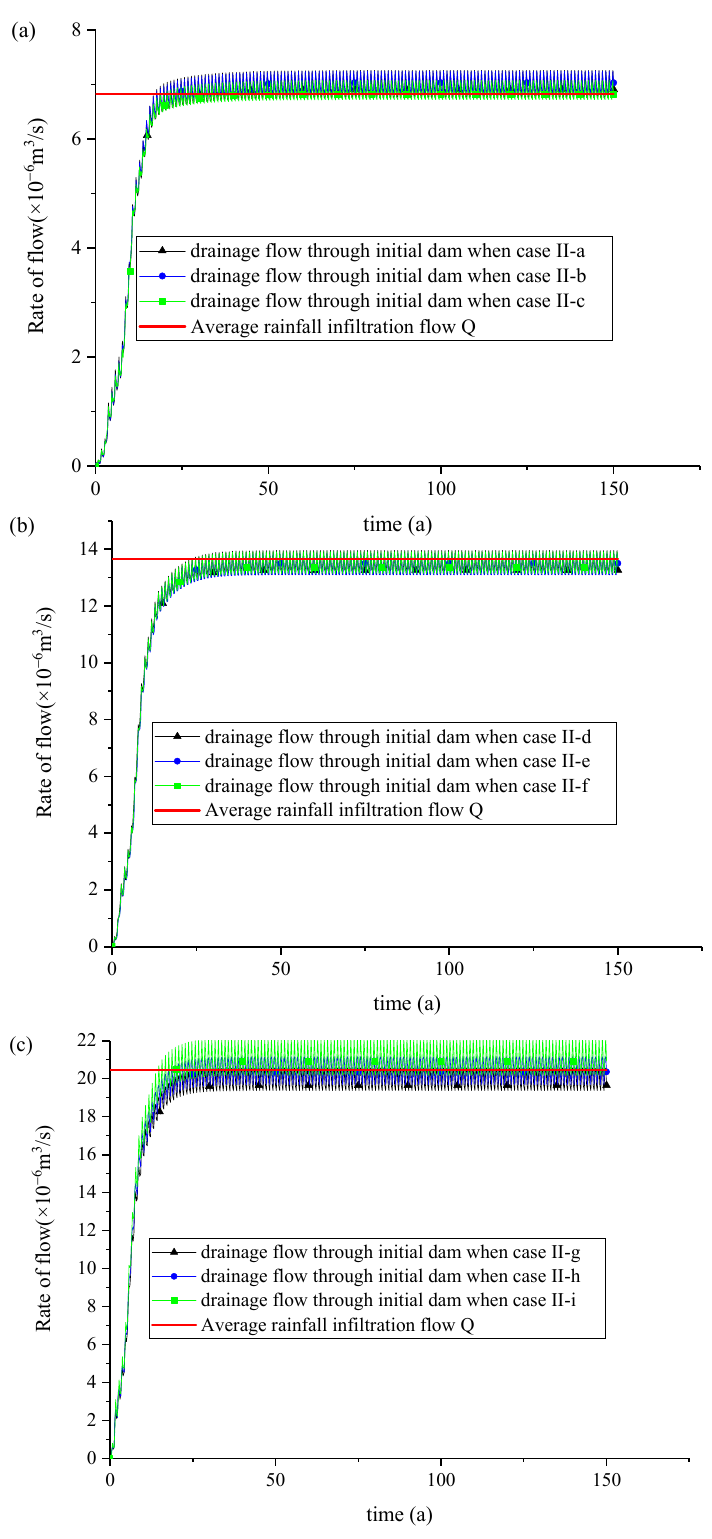
Figure 9. The variation curve of initial dam drainage flow with rainfall time: ( a ) Taiyuan (the annual rainfall of 400 mm); ( b ) Zhengzhou (the annual rainfall of 800 mm); ( c ) Guiyang (the annual rainfall of 1200 mm).